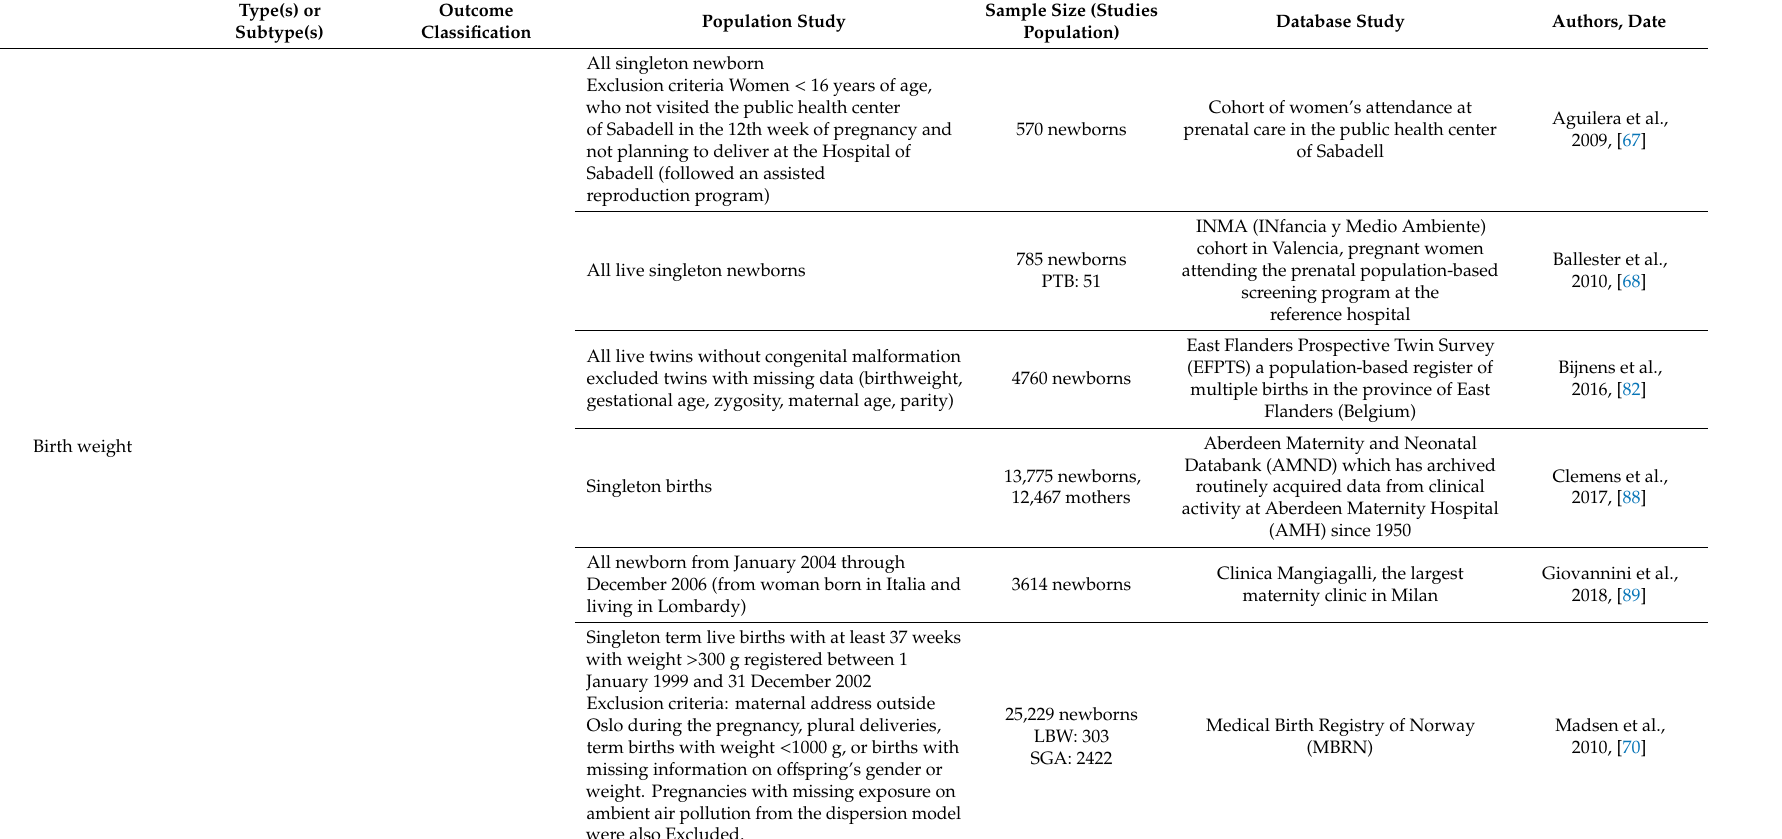
Table 2. Definitions of birth outcomes and studied population (order by